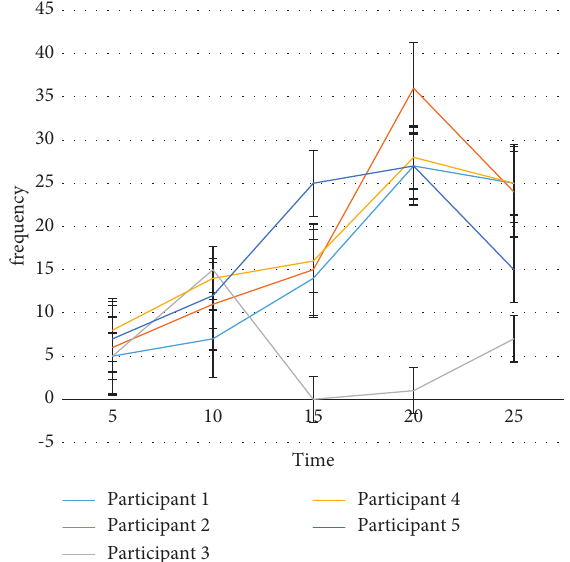
Figure 13: A statistical graph of the blink frequency of five